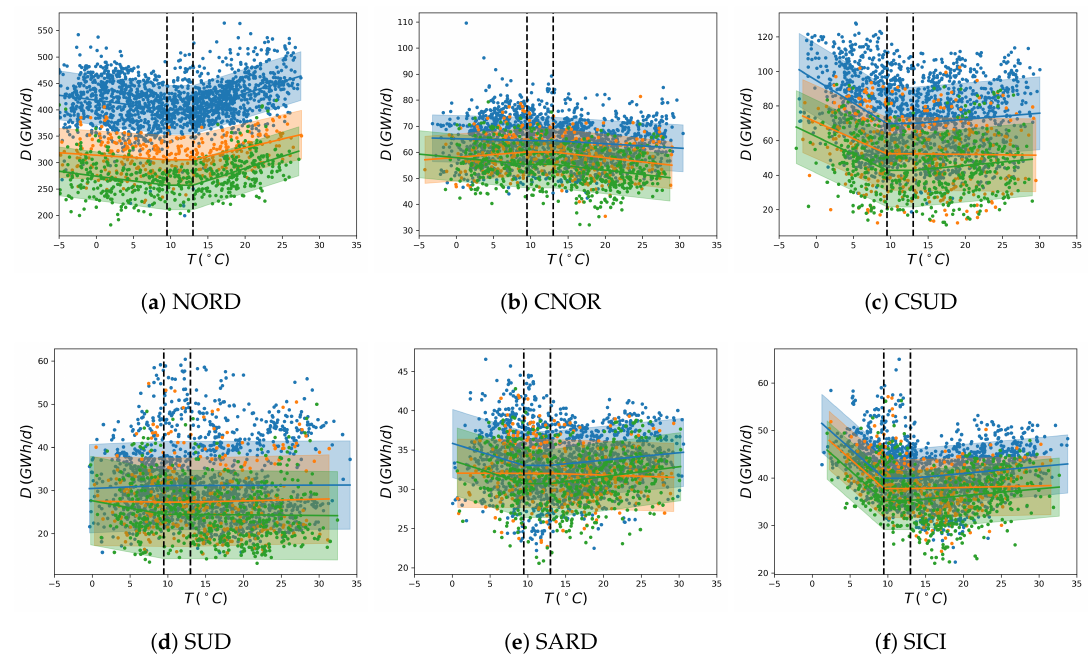
Figure A4. Daily mean electricity demand versus the surface temperature for each zone. Each point is an observed realization of temperature and demand. The lines represent the functions f work the demand model, while the associated shaded regions represent the variance of the prediction. Blue, orange and green data points and functions correspond to working days, Saturdays, and Sundays and holidays, respectively. The two vertical dashed lines represent the temperature thresholds T H = 9.5 and T C =